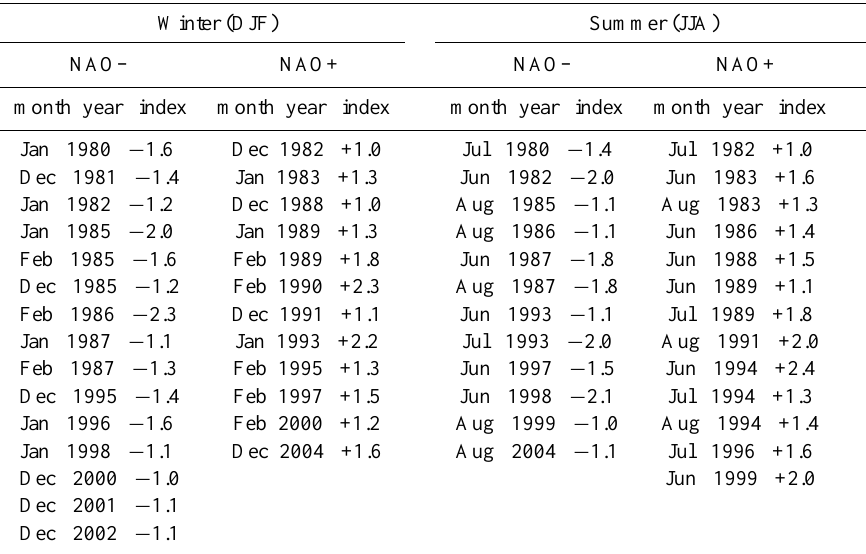
Table 2. Winter and summer months with the associated normalized PC1 used for calculating the ensemble average for positive and negative NAO